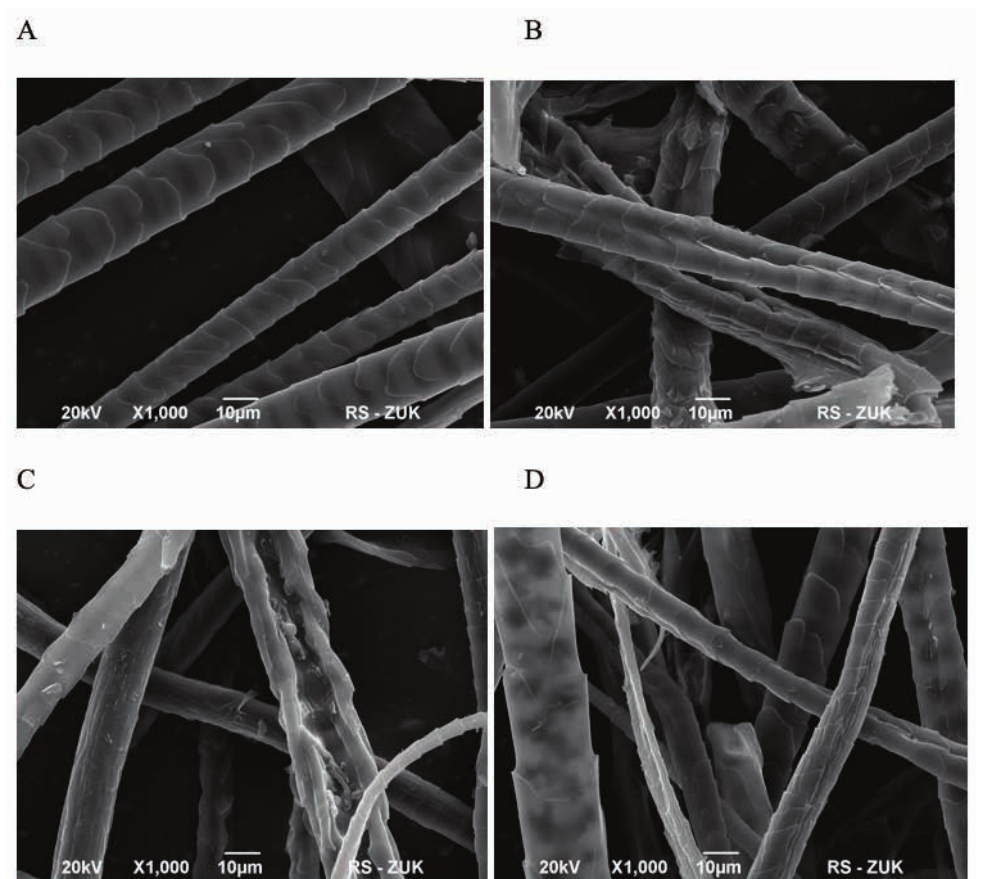
Figure 1: Macroscopic image of the scaffolds (F-KAPs) after enzyma- tic